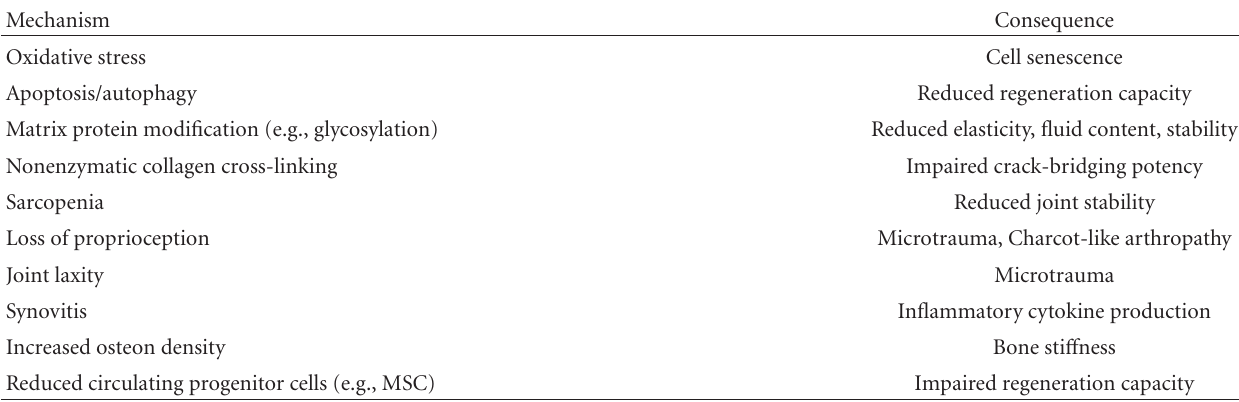
Table 1: Age-related mechanisms triggering OA.